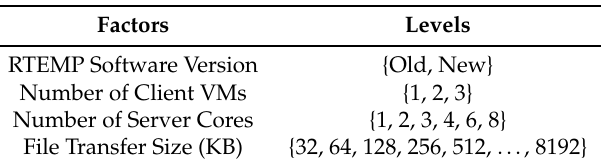
Table 1. Experimental factors and levels.